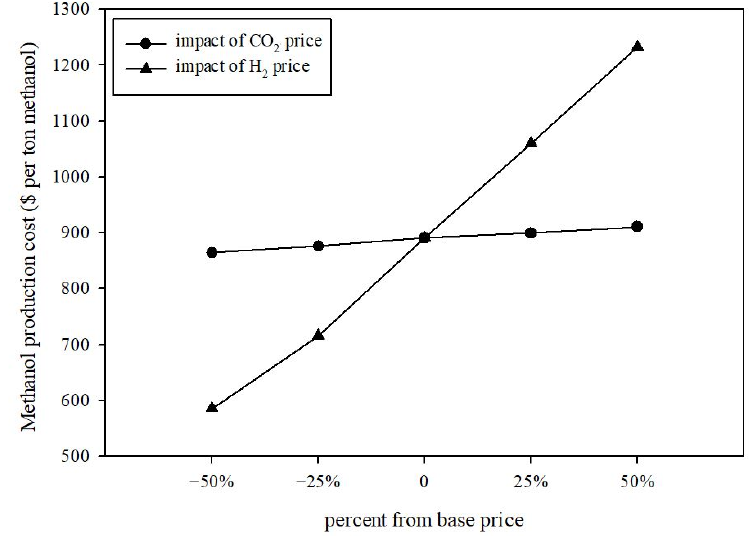
Figure 5. The impact of carbon dioxide and hydrogen prices on methanol production Figure 5 . The impact of carbon dioxide and hydrogen prices on methanol production cost .